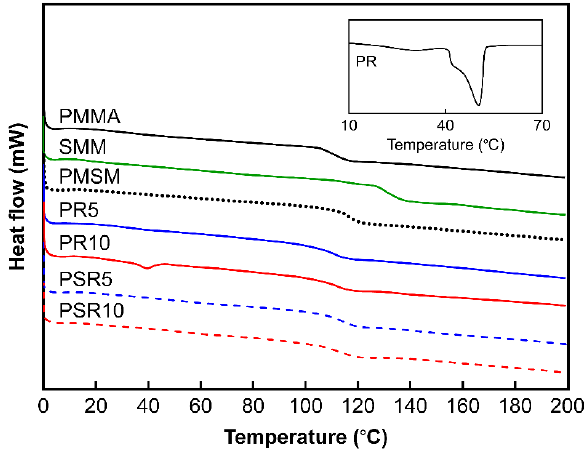
/ PR blends, and PMMA / SMM / PR